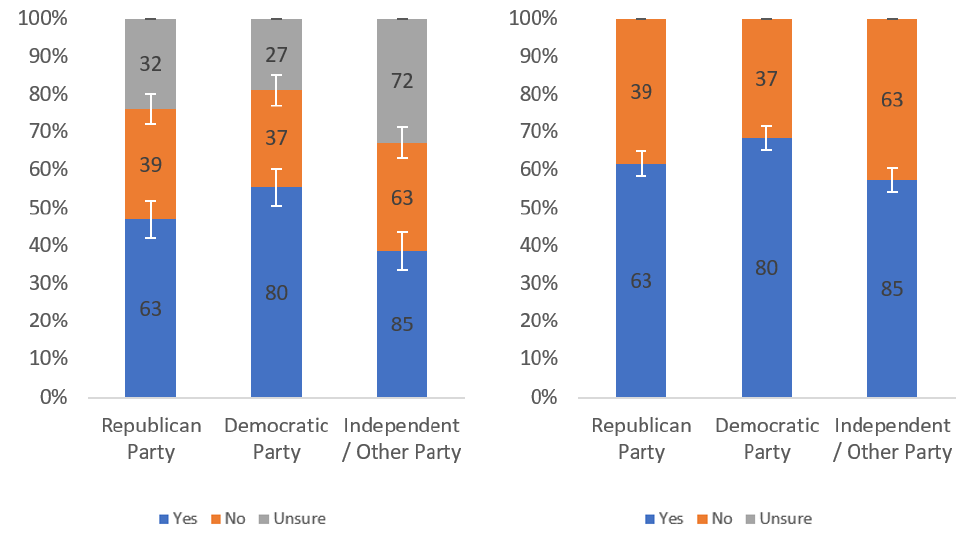
Figure 65. Responses regarding others’ willingness to review by party affiliation including ( left ) and excluding ( right ) unsure responses.